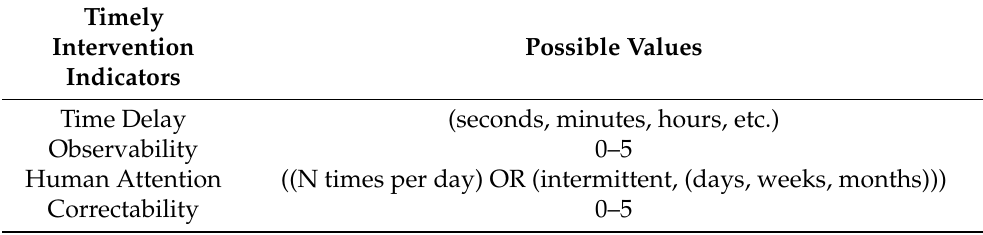
Table 1. Reference table for timely intervention indicators: time delay, observability, human attention, and correctability measures.